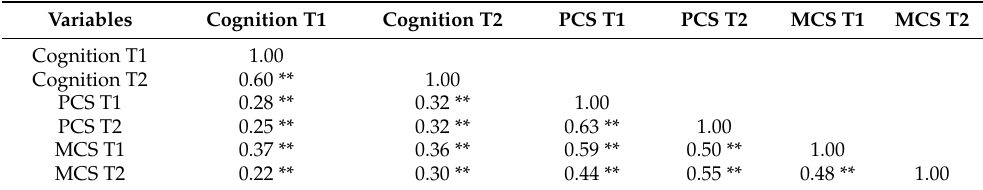
Table 4. Correlations between Cognitive Function and HRQoL ( n =